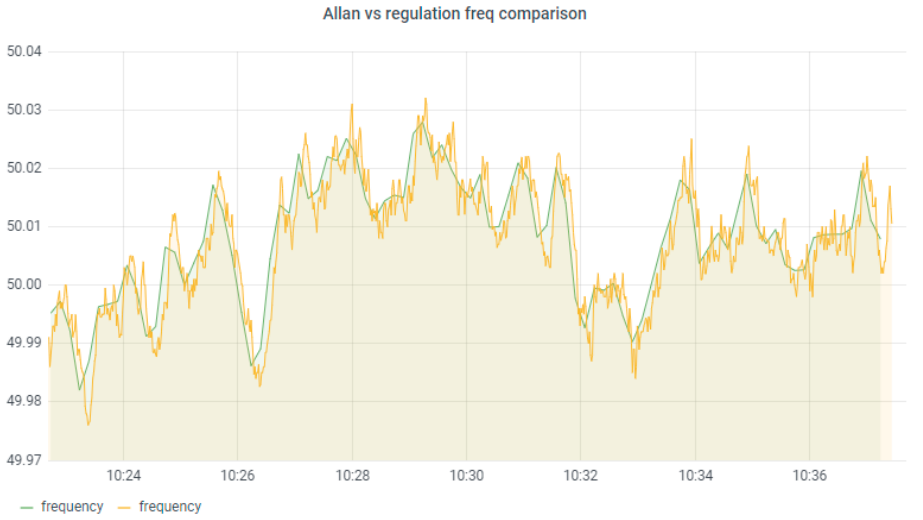
Figure 11. Frequency timeline following the regulation (green line) and following the algorithm using Allan Variance (orange line).